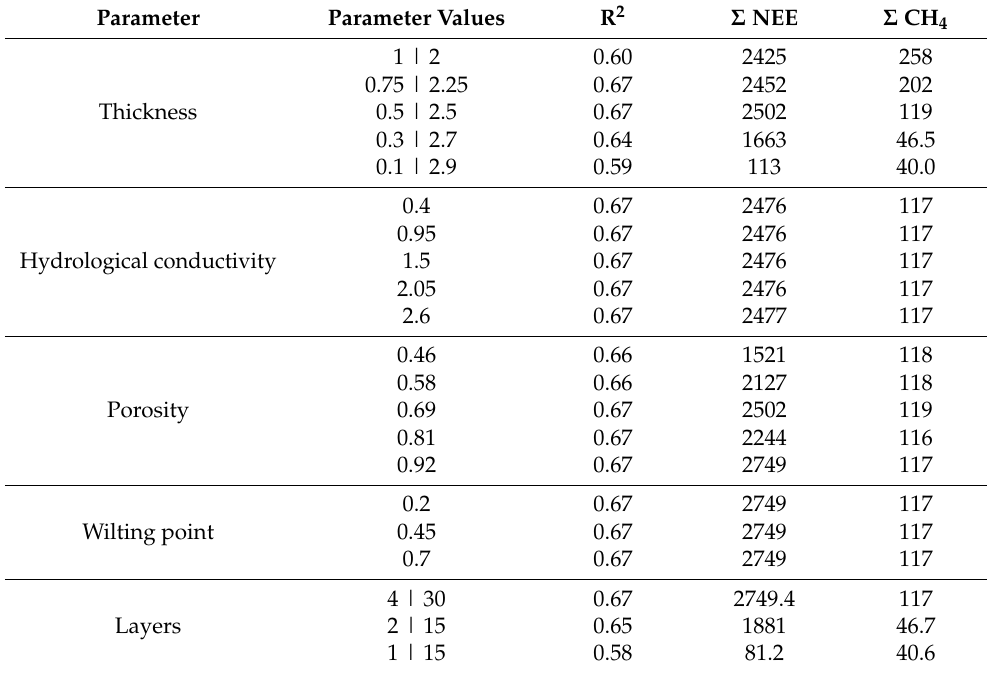
Table 1. Modelled annual variants of the Wetland-DNDC sensitivity analysis for input interval parameters of soils.